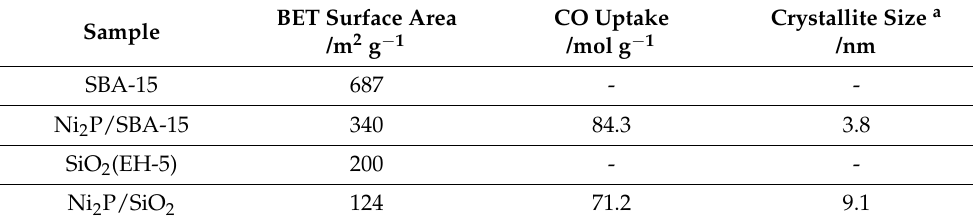
Table 1. Physicochemical properties of supported Ni 2 P catalysts.